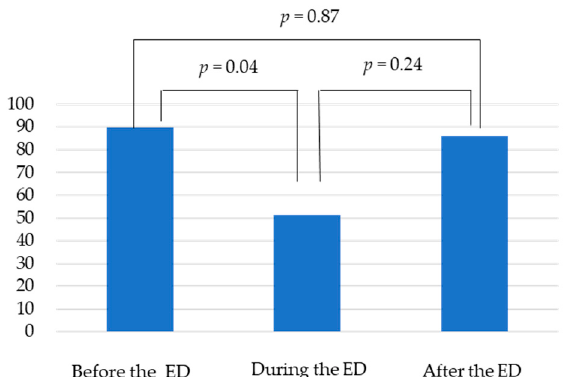
Figure 1. There were no significant differences among the three groups in the number of EUS per month (89.8/51.5/86.0 cases). Multiple comparisons showed a significant reduction between before and during the ED ( p = 0.04). and during the ED ( p = 0.04). Table 2. The number of biliary and pancreatic endoscopes at each period (monthly average). Before the ED During the ED After the ED p Value Duration